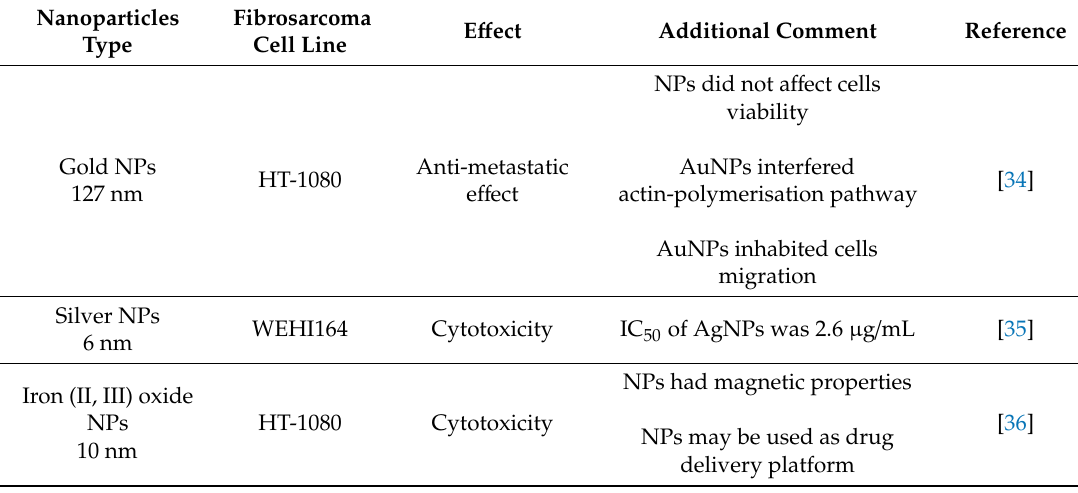
Table 2. Summary of NPs e ff ects in in vitro model of